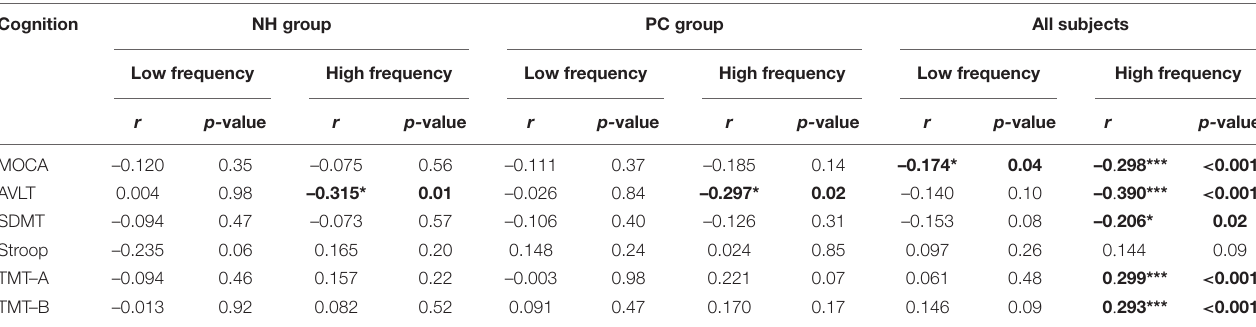
Asterisk values in bold indicate a statistically significant difference with a p-value < 0.05. *p < 0.05 and ***p < 0.001. Stroop, Stroop Color-Word Interference